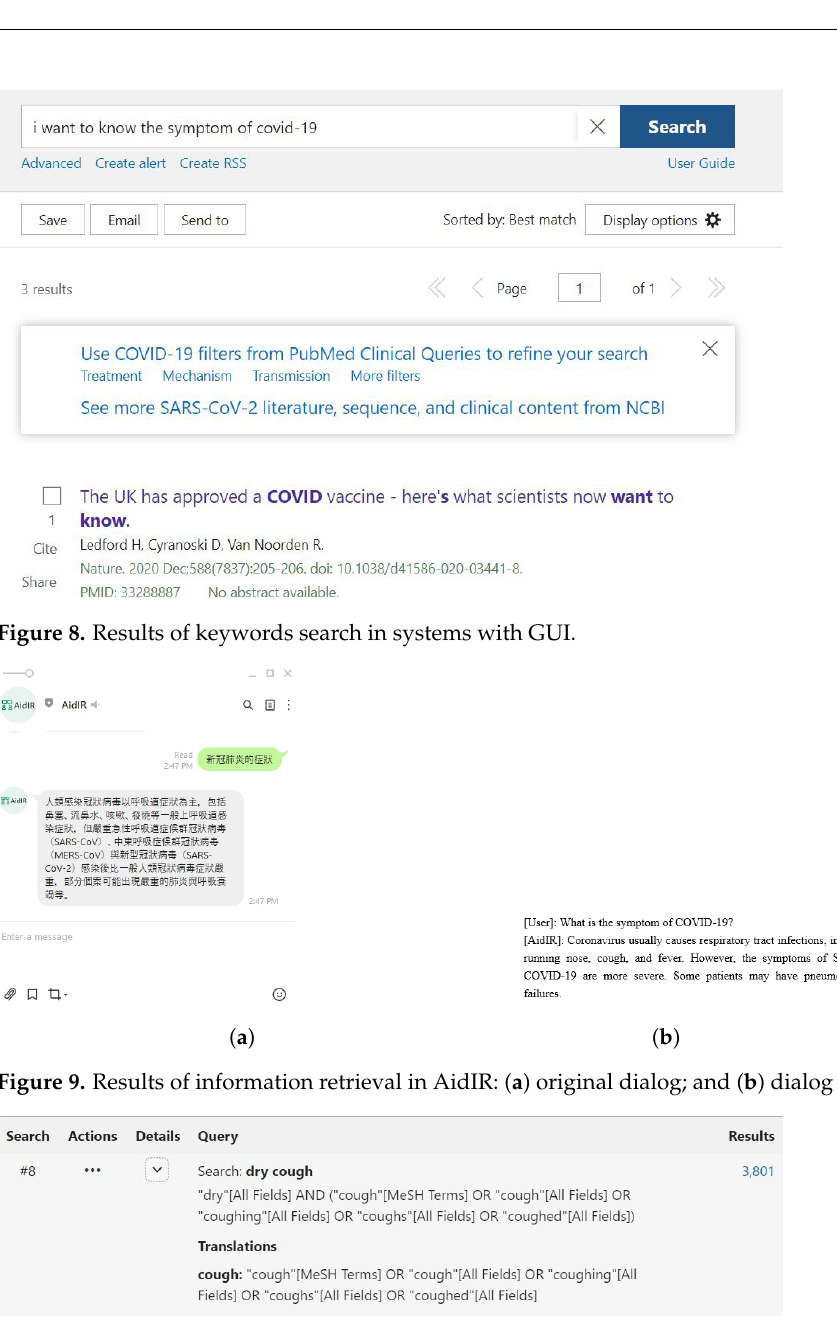
Figure 10. Results of keywords process in systems with